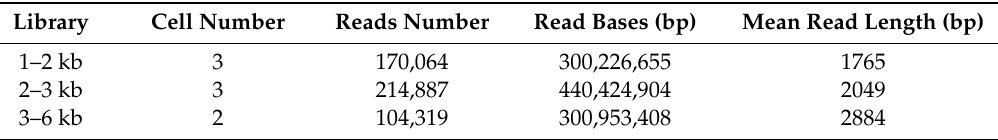
Table 1. Summary of reads information for libraries of each